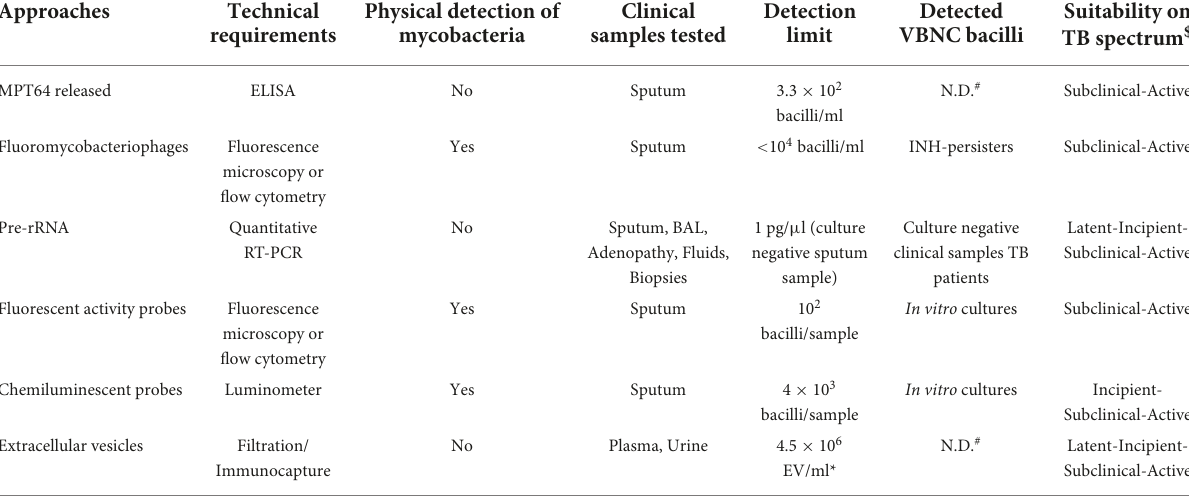
TABLE 1 Approaches to detect viable bacilli in the context of Tuberculosis disease.